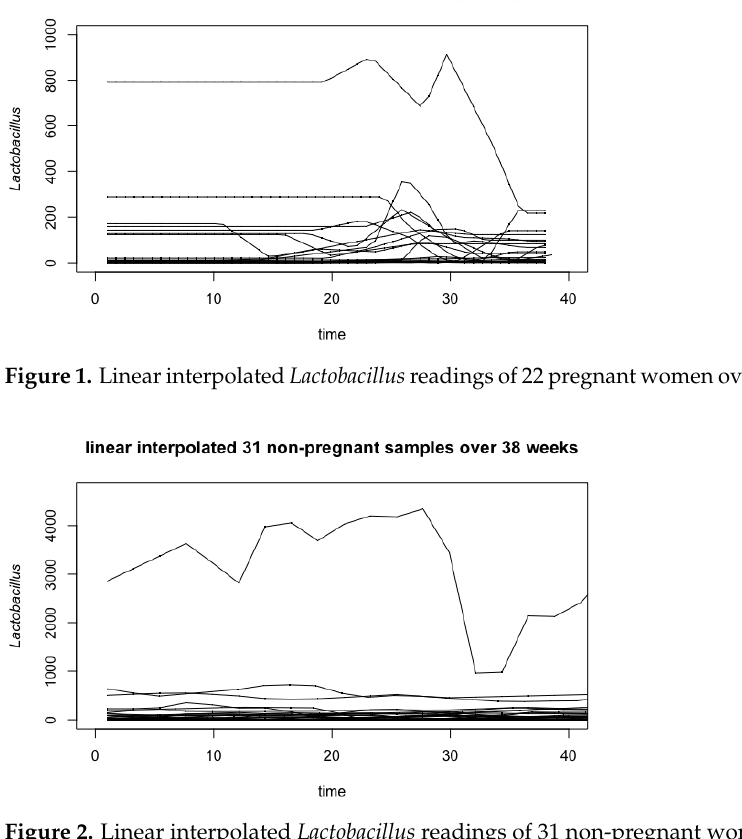
Figure 2. Linear interpolated Lactobacillus readings of 31 non-pregnant women over 38